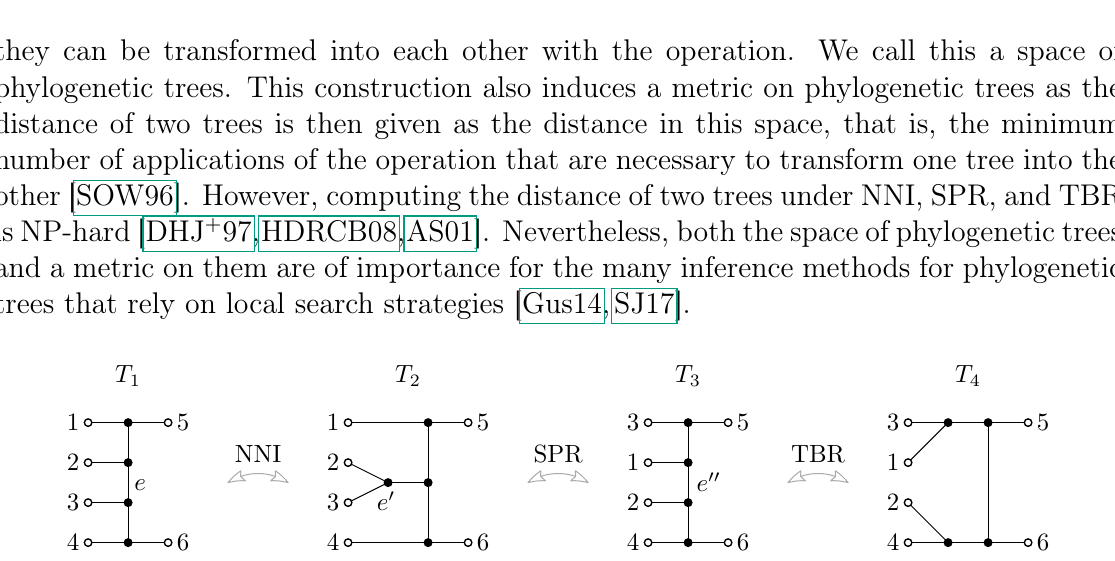
to T 2 3 to T first removes 3 4